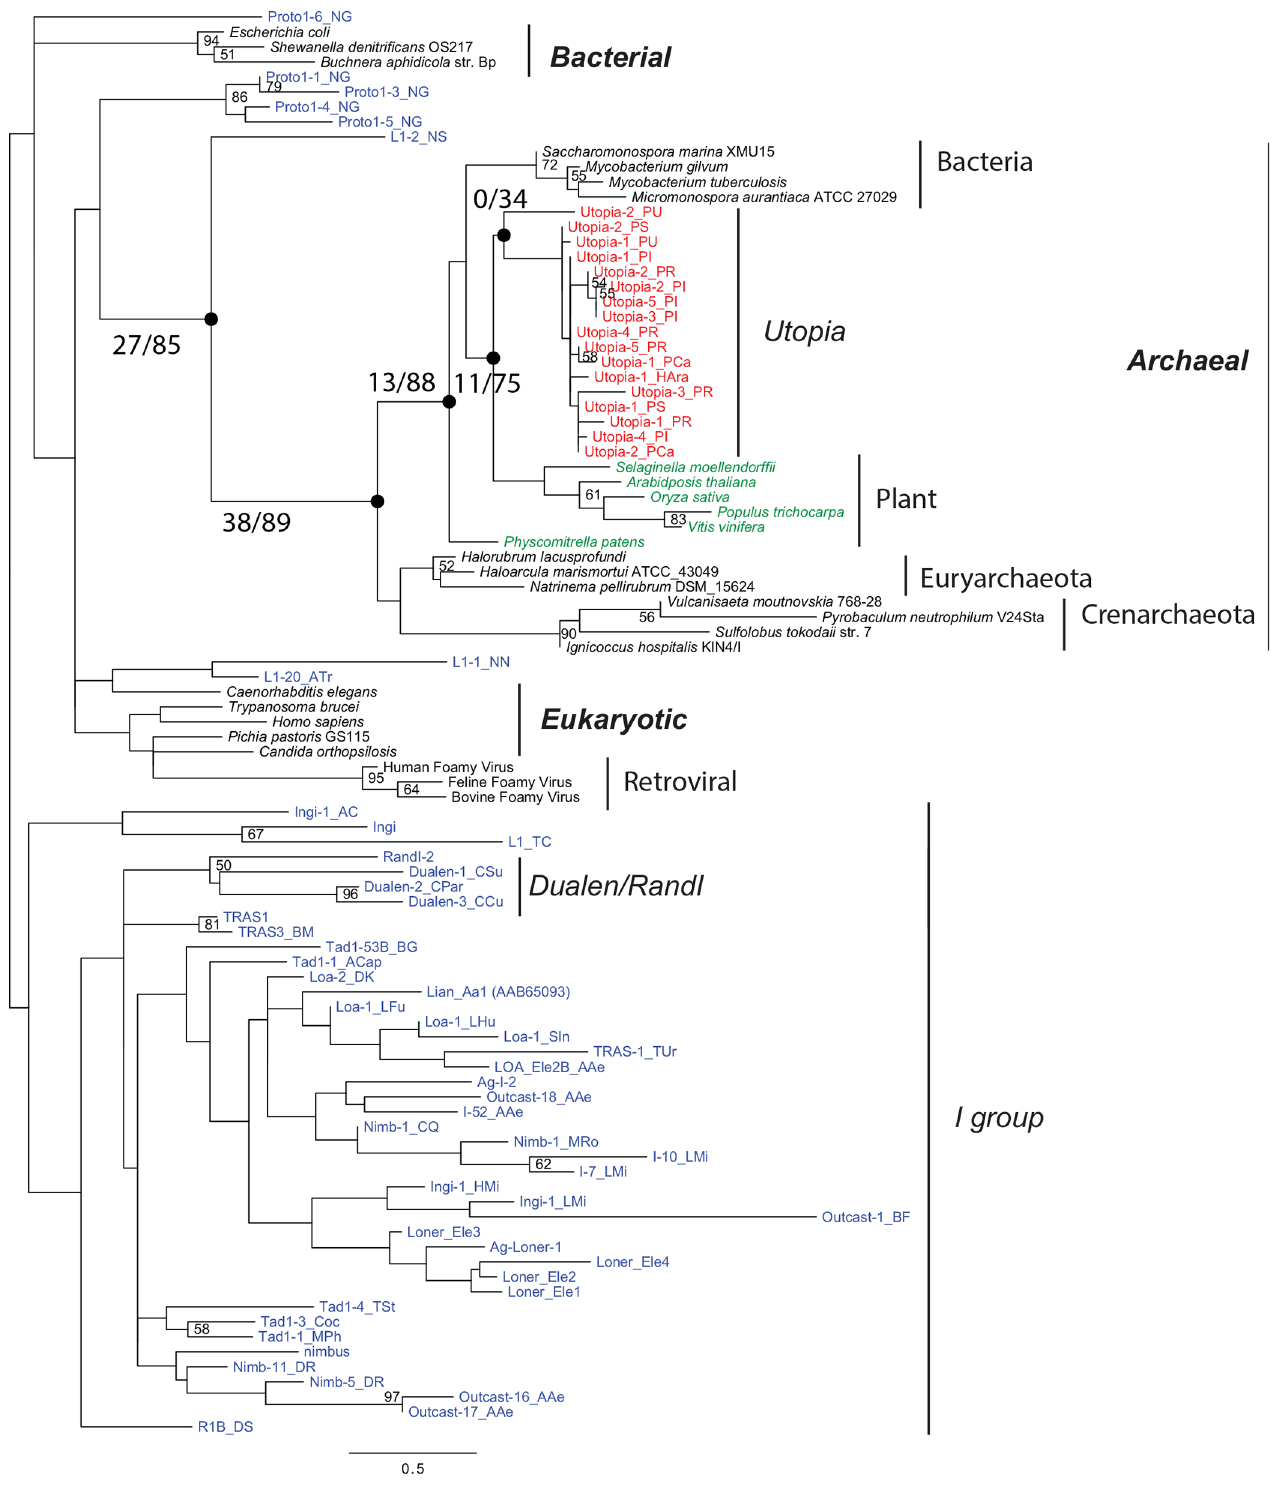
Fig 4. The phylogeny of RNase H domains from oomycete Utopia families, other non-LTR retrotransposons, and cellular RNase H genes. Cellular RNase H domains used here are identical to those in [34]. Numbers at nodes indicate bootstrap values of 100 replicates; only values over 50 are shown. We show bootstrap values and aLRT values at 5 nodes. The RNase H domains of Utopia are colored in red, those of plant are in green and those of other non- LTR retrotransposons are in blue.